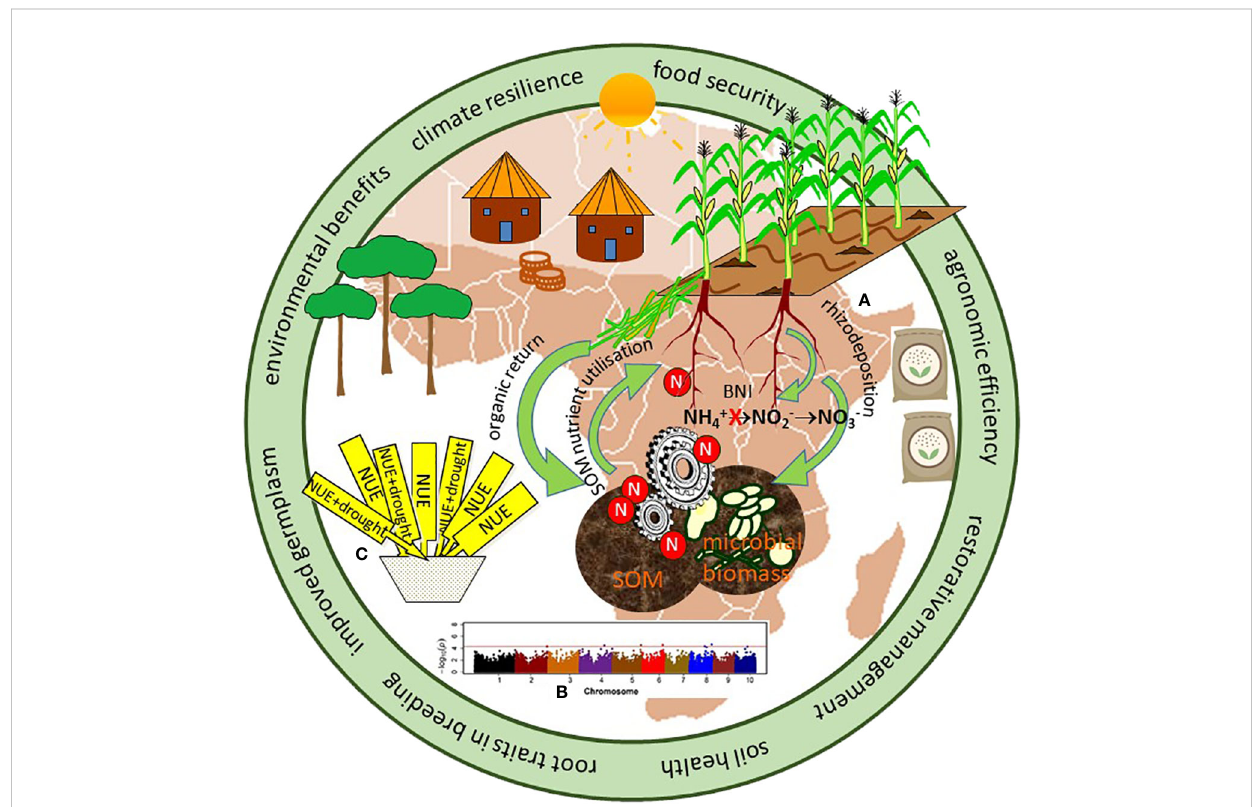
FIGURE 1 Conceptual representation of our proposed circular nutrient economy and root trait approach to inform breeding for germplasm to enhance agronomic ef fi ciency, climate resilience, and food security. Discussion highlighted in this article is indicated as (A) harnessing root-soil interactions, (B) advances in genetic approaches underpinning a root trait approach to breeding, and (C) deploying root-soil interactions into breeding